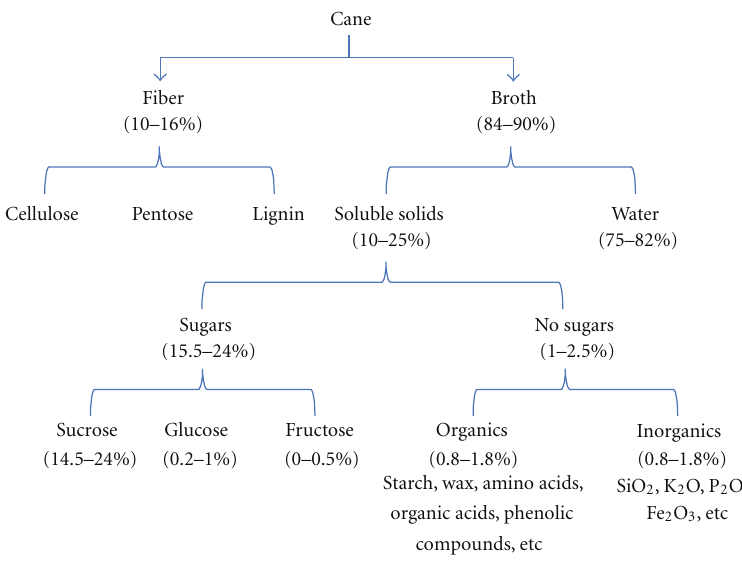
Figure 3: General composition of Sugarcane. Adapted from [13].